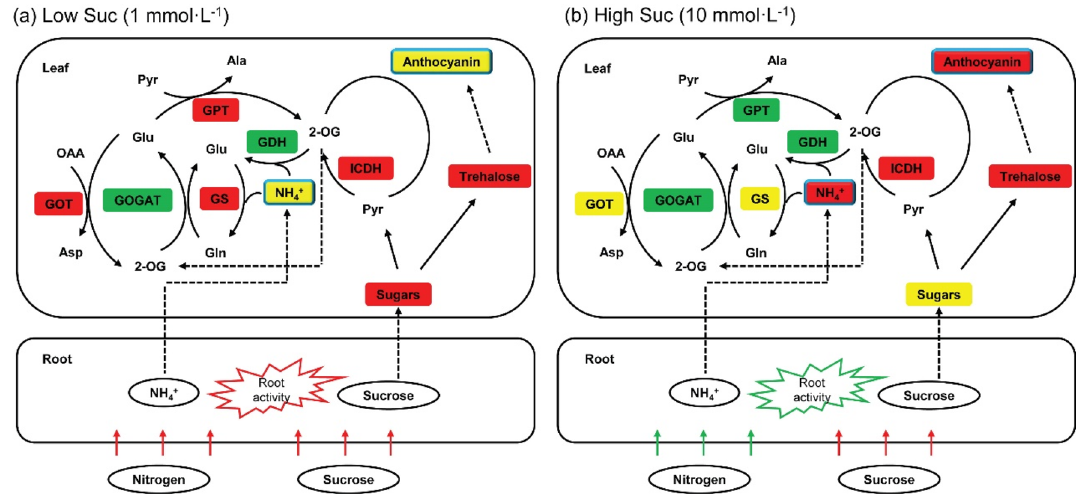
Figure 7. Simplified representation of the effect of exogenous Suc concentration on C and N metabolism in A. paniculata . ( a ) Effects of 1 mmol L −1 Suc on plant metabolites and enzyme activities in comparison to the control. ( b ) Effects of 10 mmol L −1 Suc on plant metabolites and enzyme activities in comparison to 1 mmol L −1 Suc. Red lines and boxes represent significant increase, green lines and boxes represent significant decrease, and yellow boxes represent unchanged. NH 4 + and anthocyanin were highlighted by blue wireframe, because they are key products of N and C metabolism, respectively, whose changes were closely related to the differential responses of plants to exogenous